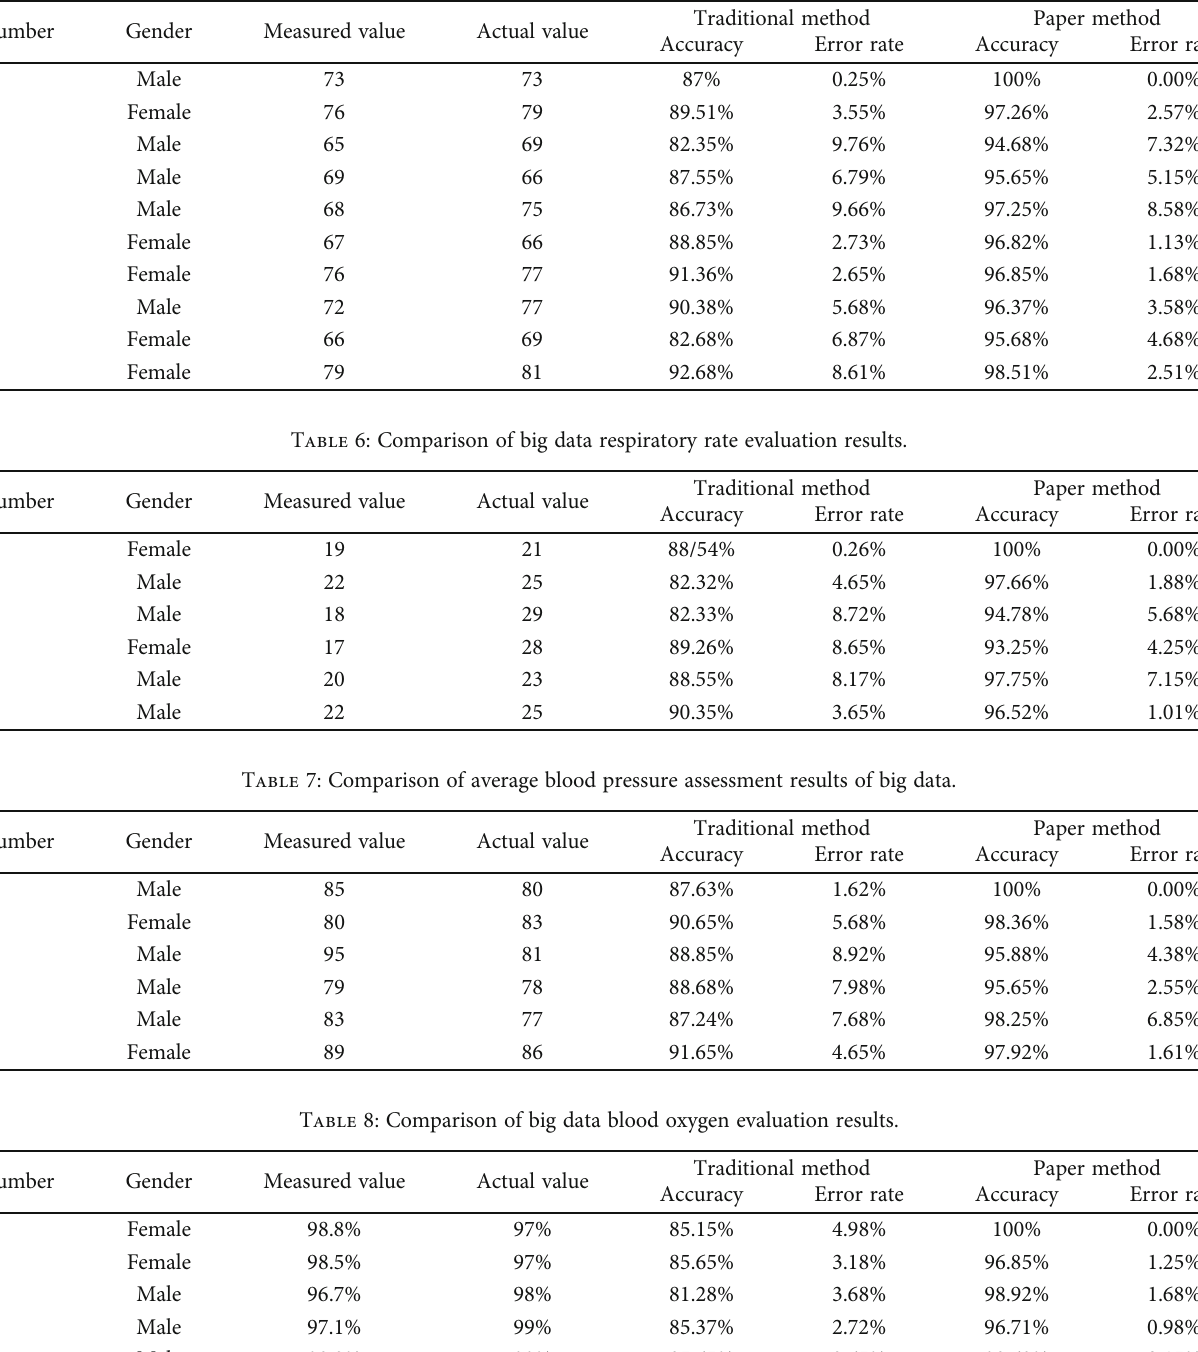
Table 5: Comparison of cardiopulmonary function evaluation results of big data.